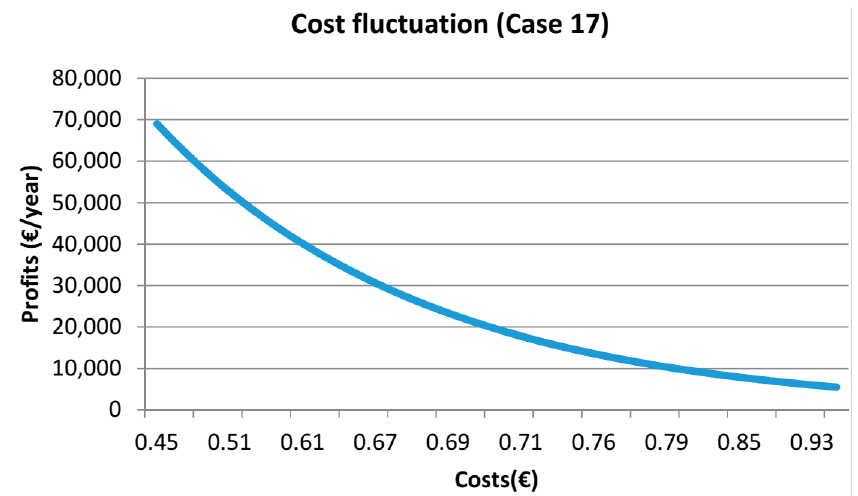
Figure 3. Profits obtained for the product 2 and case 17 versus costs.